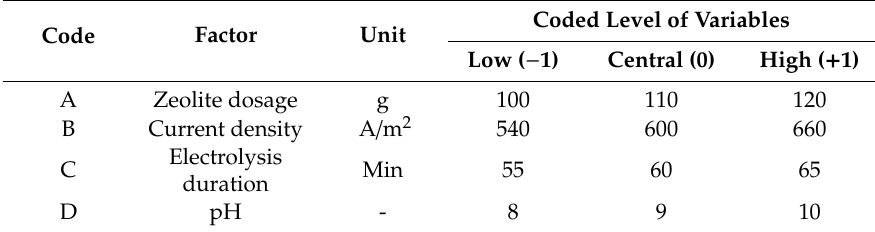
Table 2. The coded and actual values of variables for the zeolite augmented on the electrocoagulation process (ZAEP) treatment.